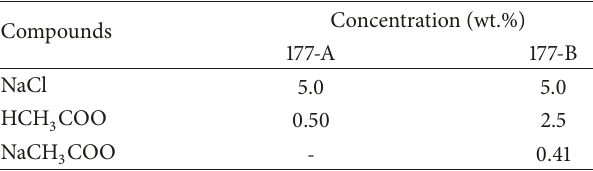
Table 3: Chemical composition of solutions 177-A and